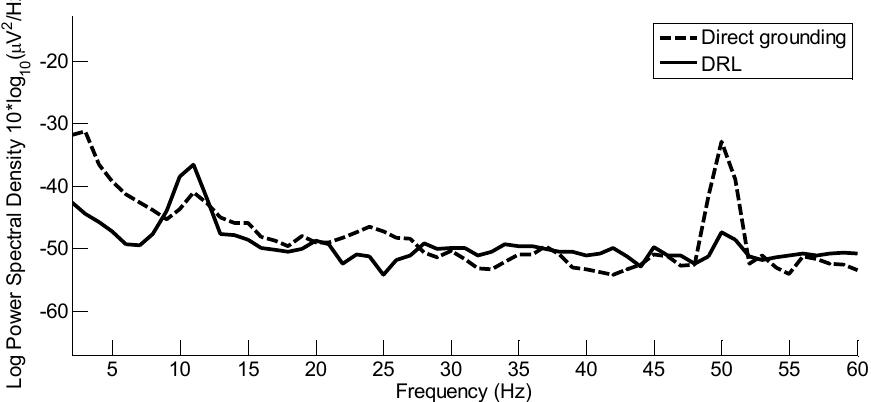
Figure 9. Power ‐ line noise capture comparison. Bold trace is with the use of the Driven Right Leg (DRL), which reduces the power ‐ line noise capture by at least 10 dB.